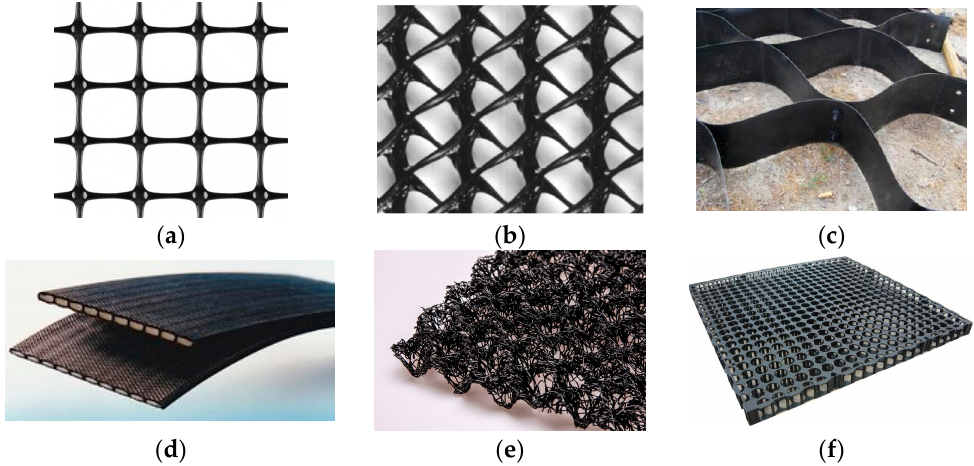
Figure 4. Examples of: ( a ) geogrid; ( b ) geonet; ( c ) geocell; ( d ) geostrip; ( e ) geomat; ( f ) geospacer. Geosynthetic barriers (low-permeability geosynthetic materials, used with the pur- pose of reducing or preventing the flow of fluid through the construction) are also